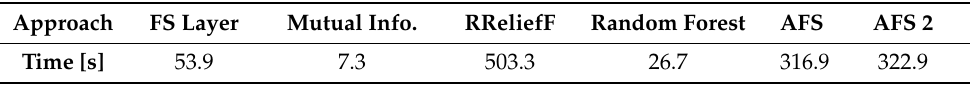
Table 13. Time duration for feature importance values generation (C-MAPSS FD001 case).